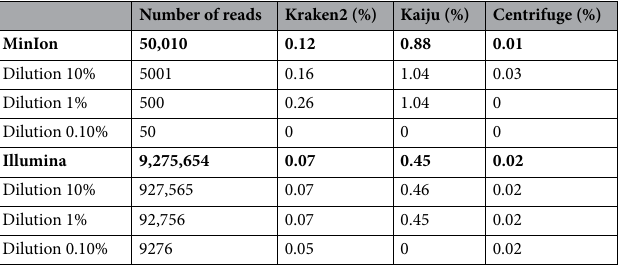
Table 1. Percentages of reads identified as an arenavirus using different classification tools. The highest number of reads classified as belonging to arenaviruses were obtained with Kaiju tool for both MinION and Illumina